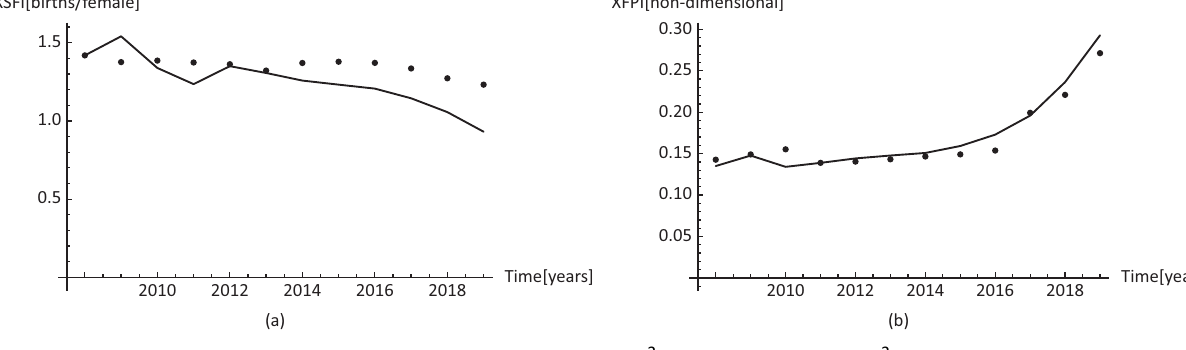
Figure 1. Validation of the model (2008–2019). Notes: (a) XSFI, R 2 = 0.79087; (b) XFPI, R 2 = 0.972928; the points indicate historical values and the lines indicate simulated